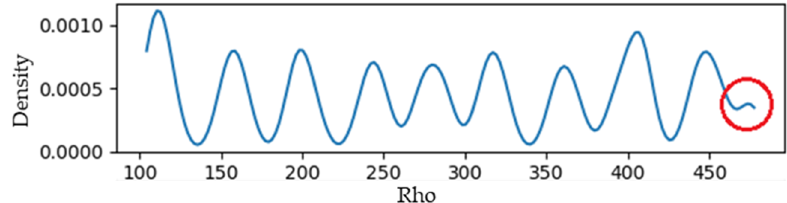
Figure 7. KDE of rho distances for vertical or horizontal group of lines. The peak in the red circle corresponds to one of the board’s edge lines .